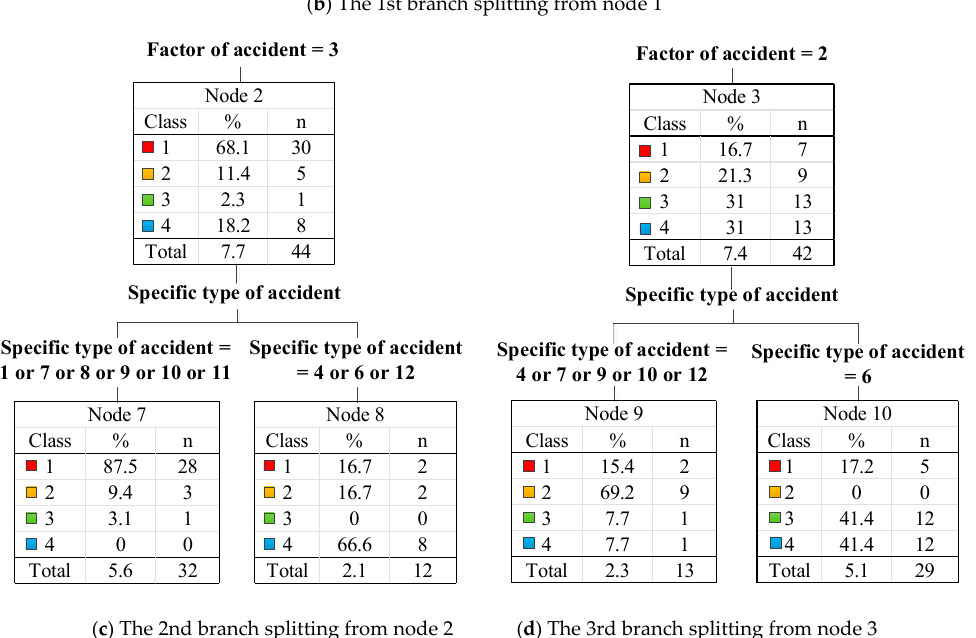
Figure 11. The decision tree model with 14 nodes, wherein Class 1, 2, 3, and 4 in each node corresponds to Level II, Level Ⅲ , Level Ⅳ , and Level V of HTAs.